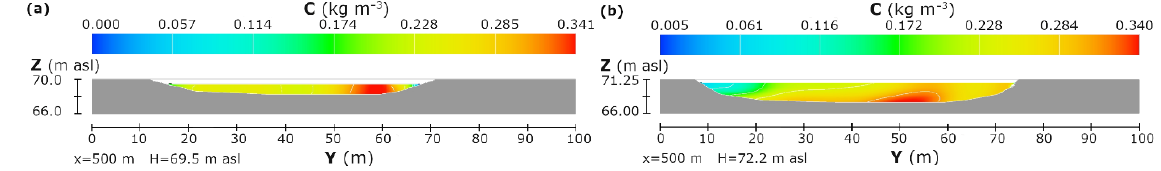
= 41 m 3 s -1 and (b) Q =318 m 3 s -1 i i